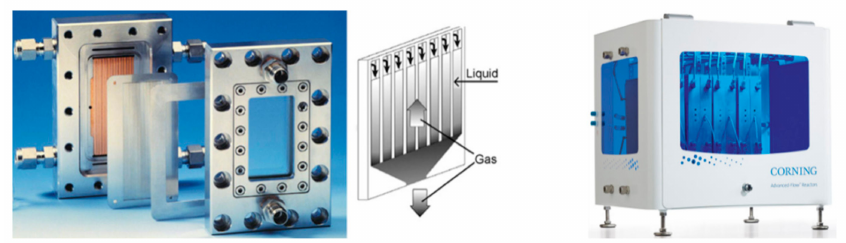
Figure 1. Images of a falling film reactor plate (reproduced with permission from [25]) and the Corning G3 photoreactor [26].